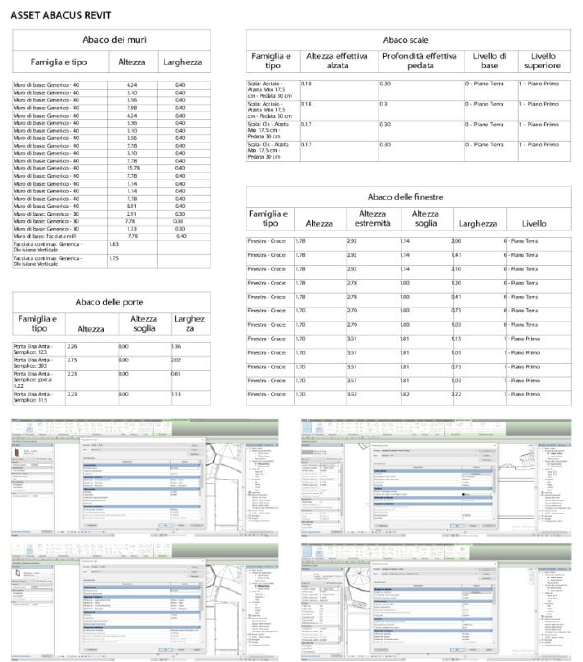
Figure 15. (B) Revit_graphic abacus of architectural